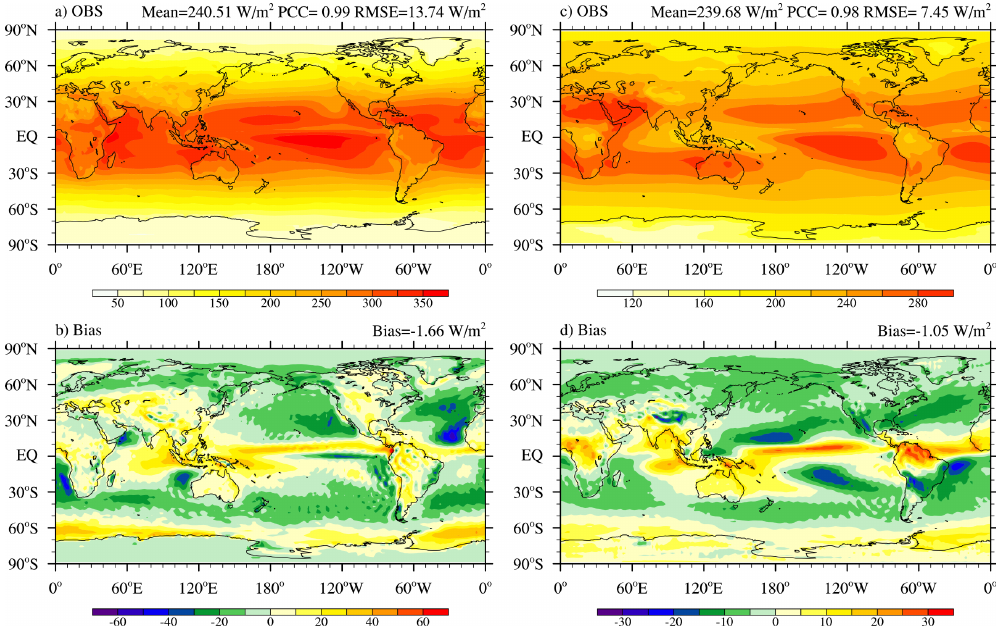
Figure 6. Annual mean TOA net shortwave radiation (a, b) and OLR ( c, d ; unit: Wm − 2 ) derived from observations (a, c) and the model bias (b, d) . The observed radiation fields were derived from the Clouds and the Earth’s Radiant Energy System (CERES) dataset (Loeb et al.,